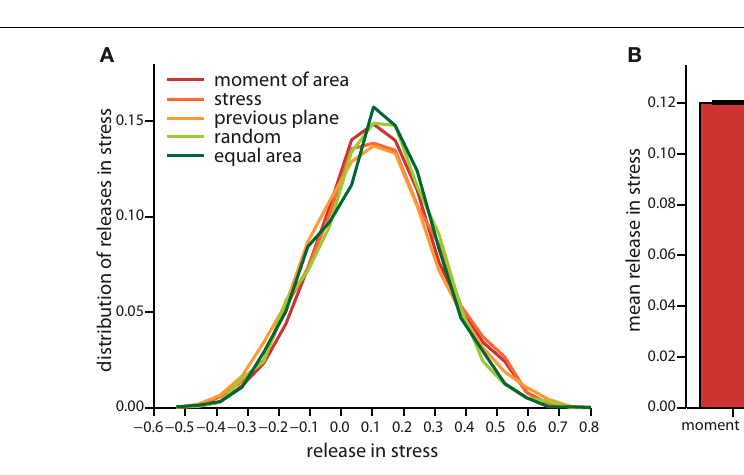
FIGURE 3 | Snapshots of the tissue simulation for different cell division modes. The color code corresponds to increasing growth rates going from dark blue to dark red.The line within each cell marks the direction of maximal growth. Strikingly the spatial variability of